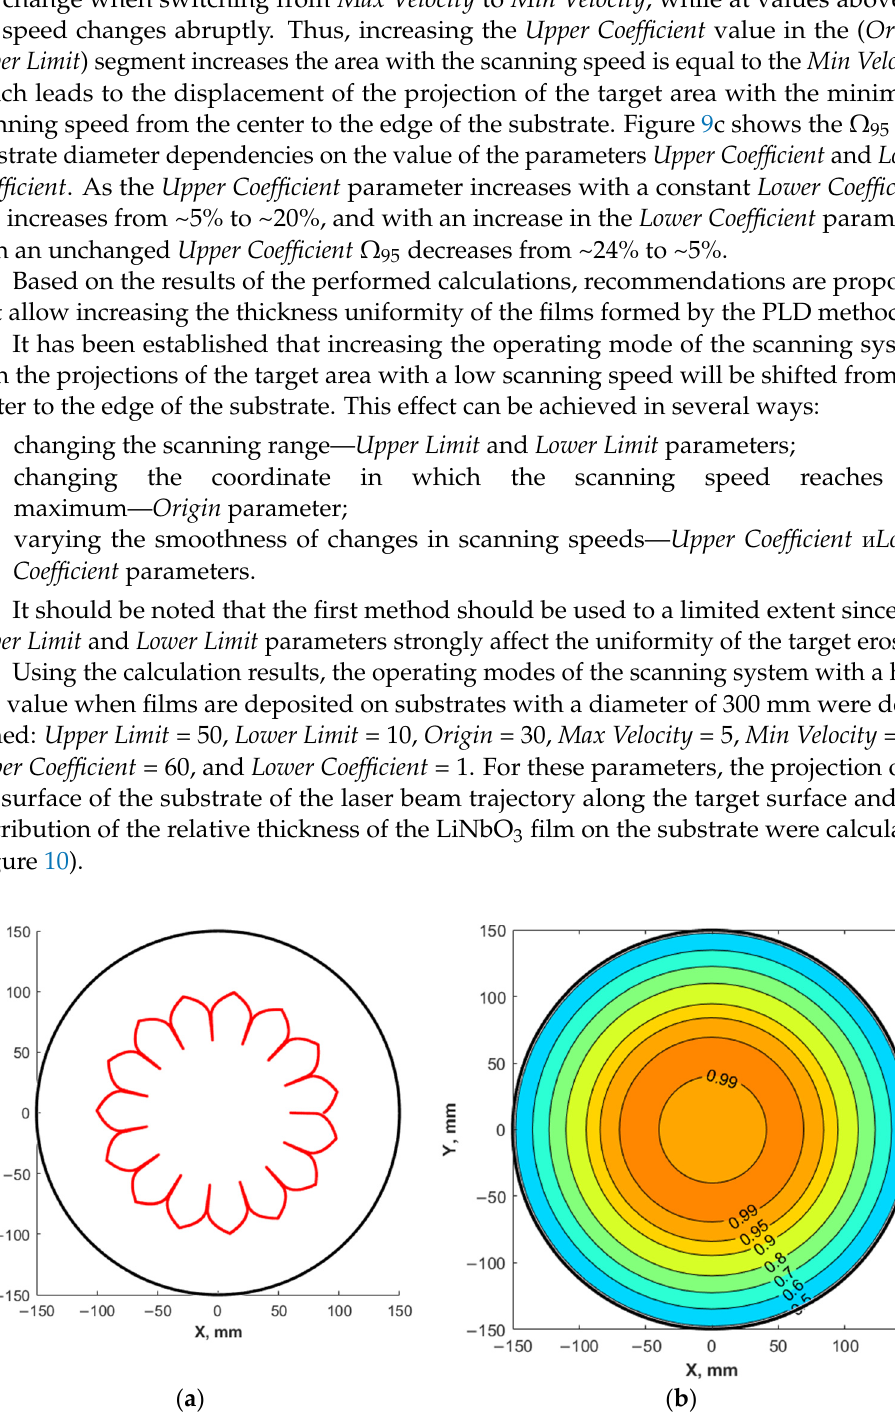
Figure 10. Projection of the trajectory of the laser beam along the target surface onto the substrate surface ( a ) and the distribution of the relative thickness ( b ) of the obtained film on a substrate with a diameter of 300 mm.